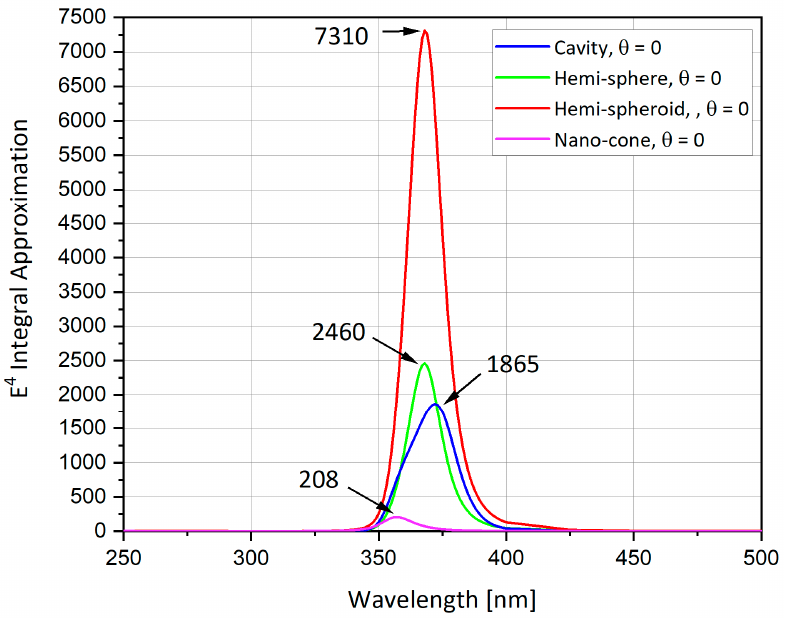
Figure 12. Surface-Enhanced Raman Scattering (SERS) EF: comparison between different nano- particle geometries.